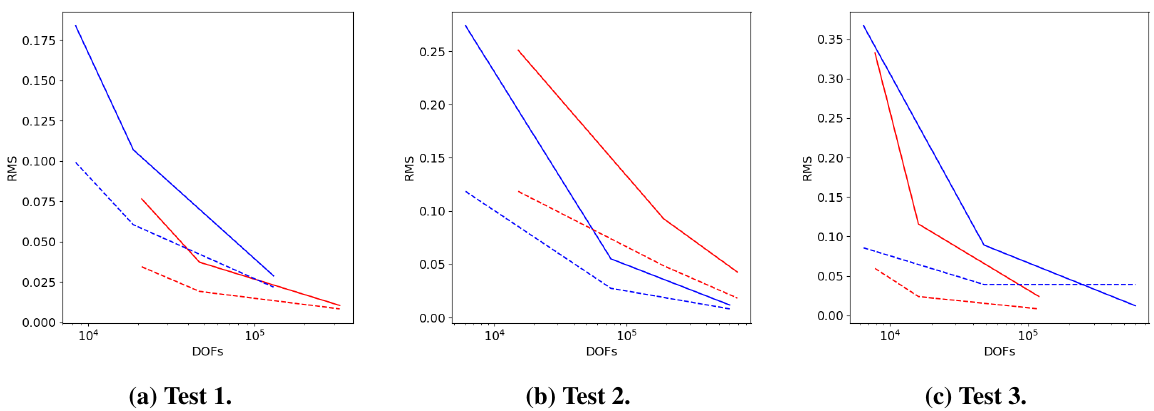
Figure 1: Root Mean Square vs number of Degrees of Freedom for linear (blue) and quadratic (red) DGFEM. Dashed: case with scattering. Solid: no